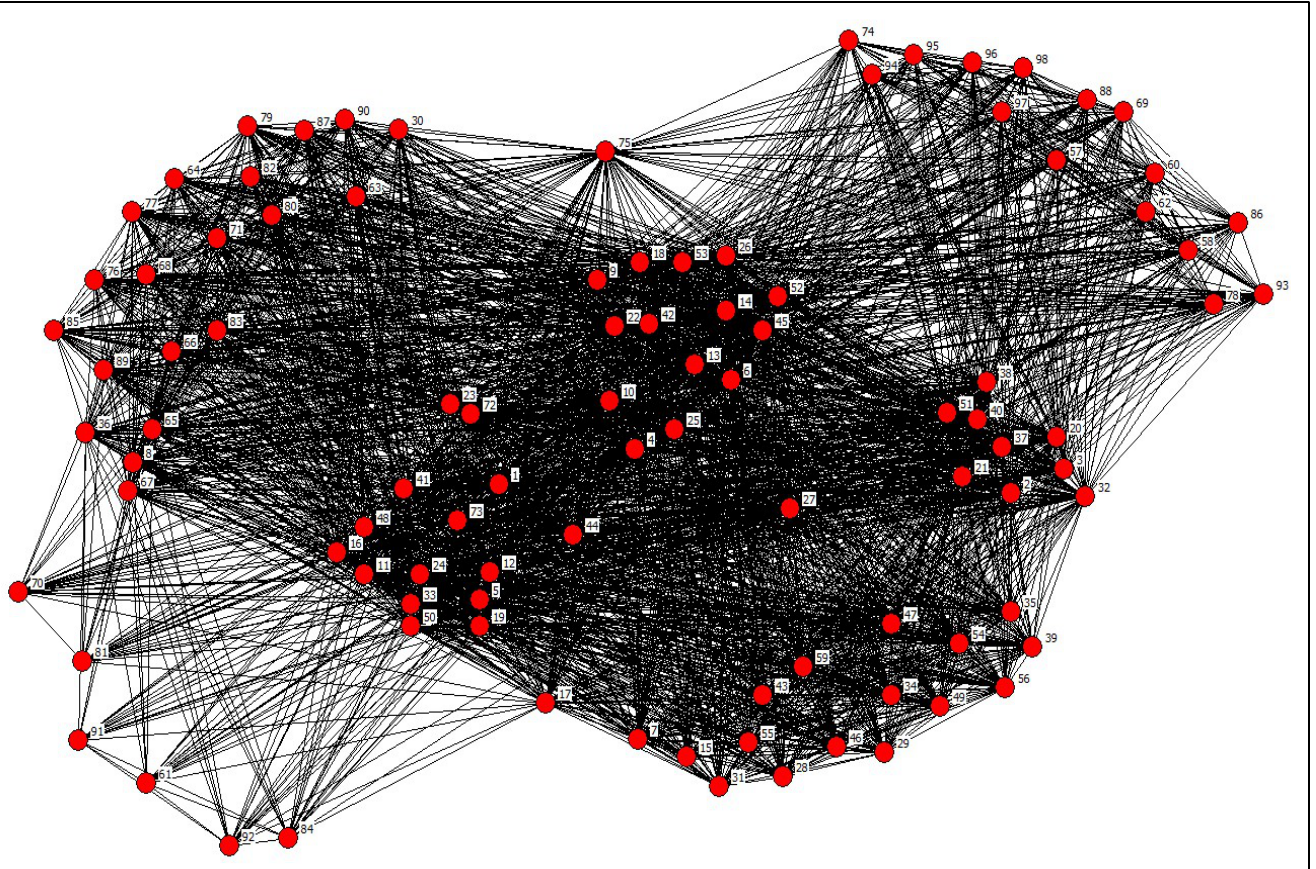
Figure 1 – The simple graph of European network governance in adult